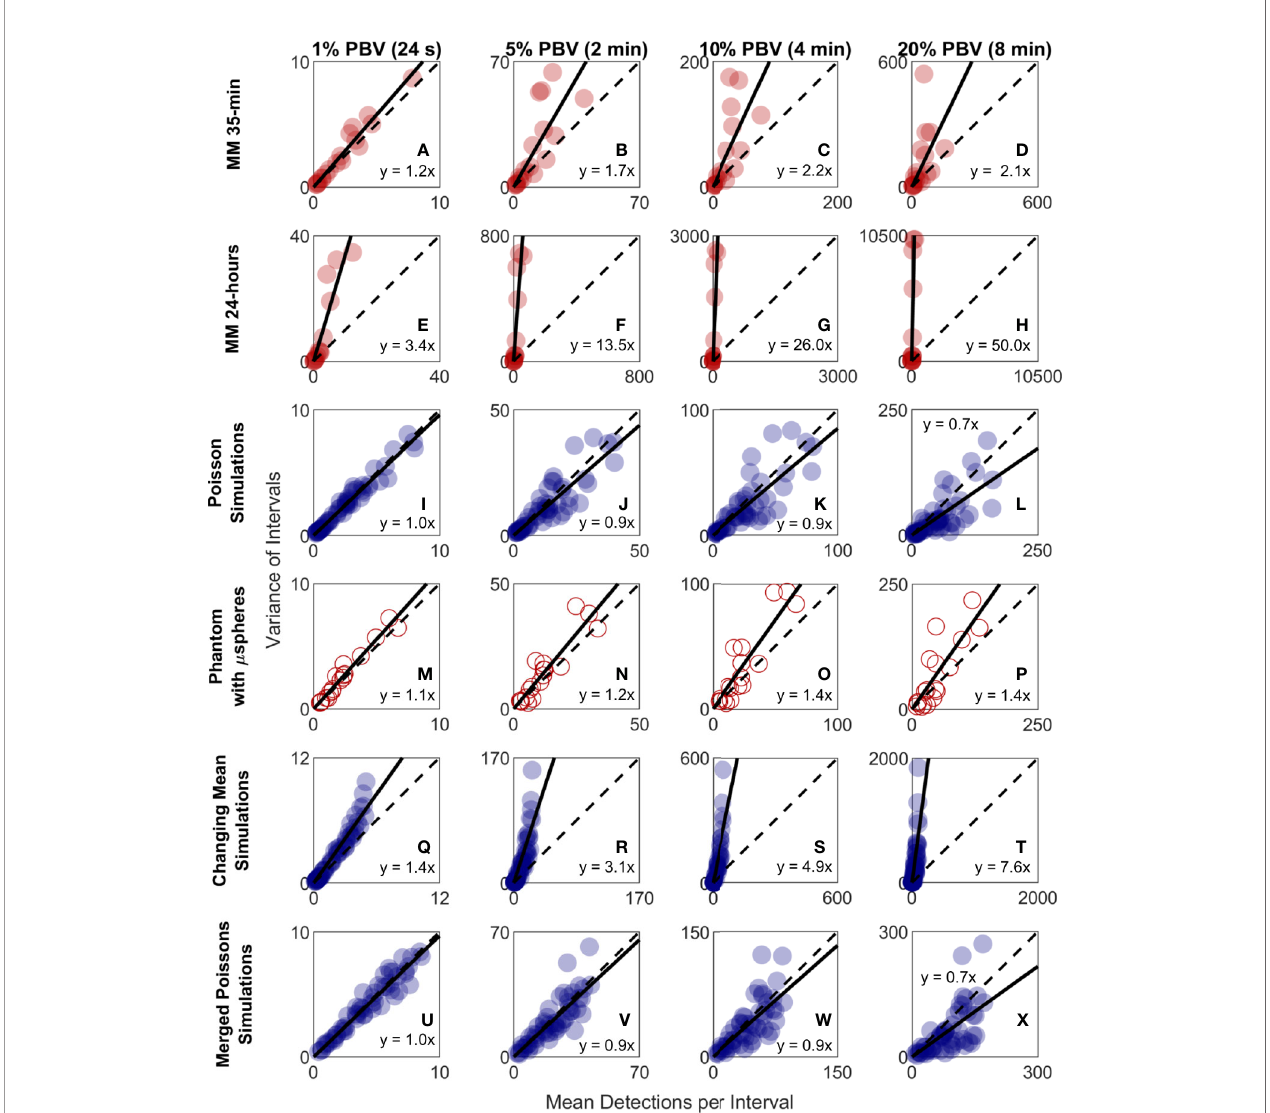
FIGURE 6 | The variability in DiFC count rate measured in mice far exceeded that expected by Poisson statistics. Measured variance in CTC counts compared to the scan mean count in DiFC data is shown for (A – D) MM 35-min mice, (E – H) MM 24-h mice, (I – L) simulated Poisson DiFC data, and (M – P) phantoms with suspensions of well-mixed microspheres. The dashed diagonal lines indicate the expected 1:1 variance-to-mean relationship for Poisson-distributed data. (Q – T) Simulations show that the higher than expected variance in MM 35-min data is consistent with a Poisson process with changing mean (see text for details). (U – X) By contrast, two or more simultaneous (merged) Poisson processes would not be consistent with the higher-than-expected variance. Equations and solid lines indicate a linear fi t to each data